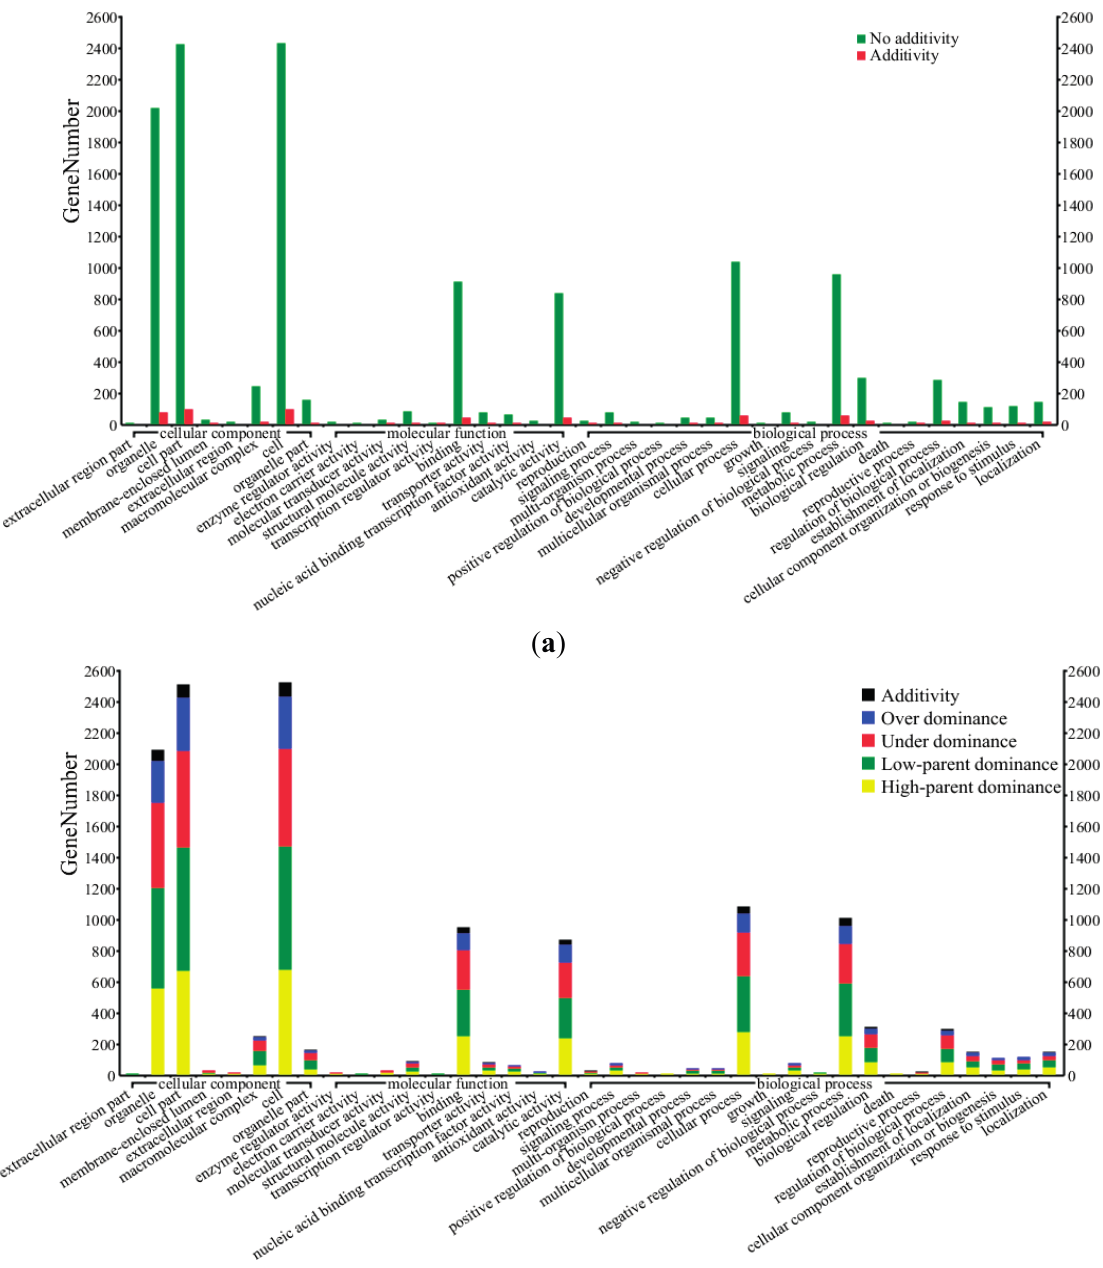
Figure 2. Functional categories of differentially expressed genes. Overall differentially expressed genes ( a ) and non-additive expressed genes ( b ) from B73 × Mo17